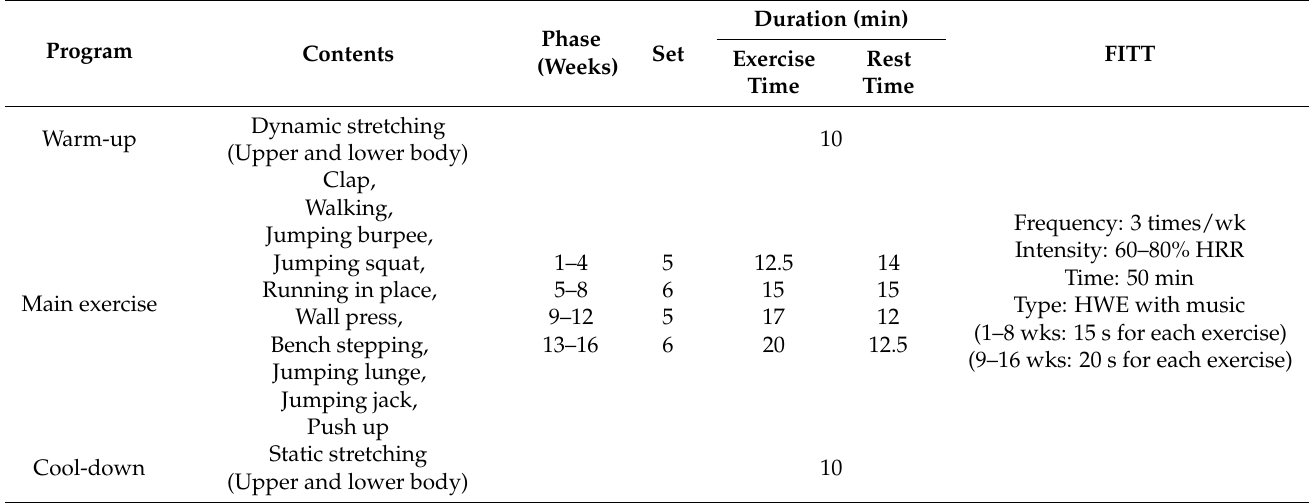
Table 2. High-impact weight-bearing exercise program for the four-months of the